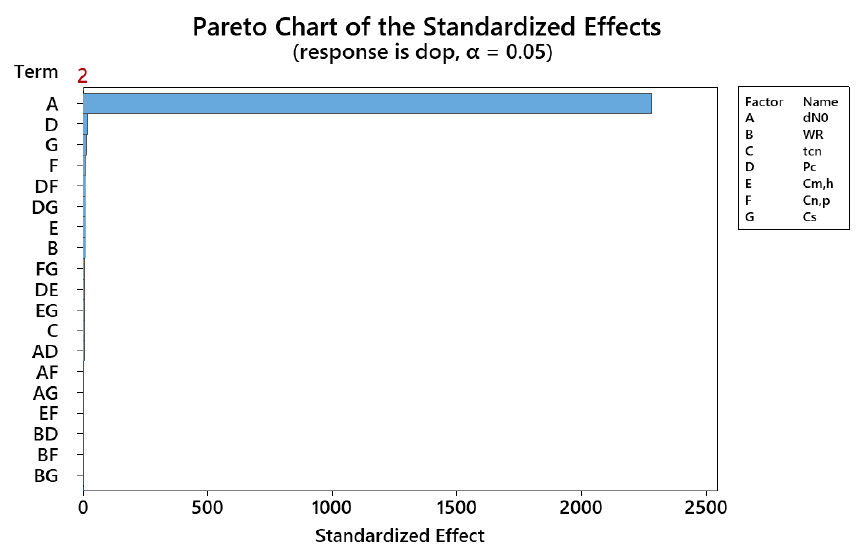
Figure 7. Pareto chart of the standardized effects.